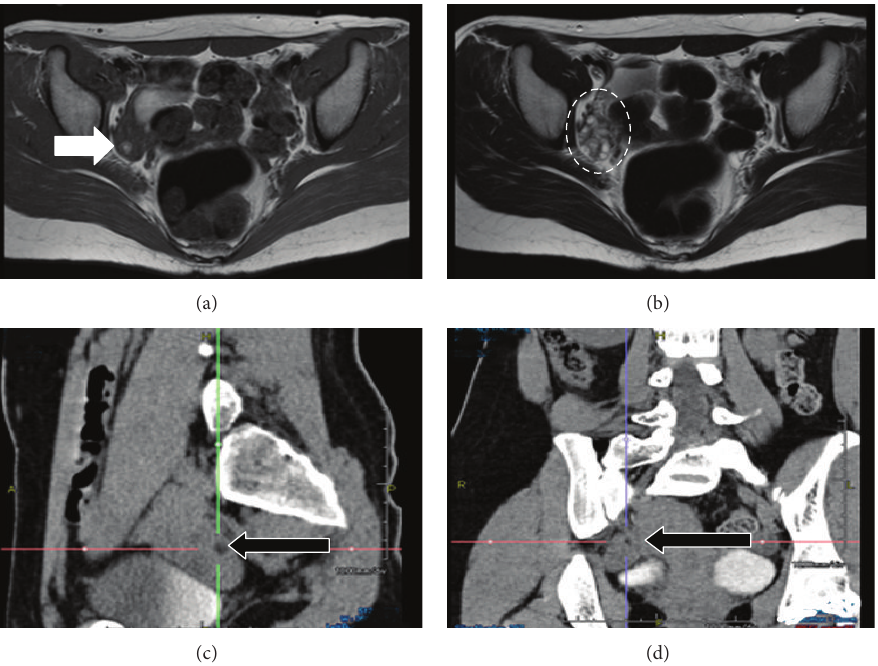
Figure 1: Image diagnosis. (a) T1-weighted transverse pelvic MRI; open arrow indicates a 5×7 mm high-intensity area in the right ovary that shows a fat component of the ovarian teratoma. (b) T2-weighted transverse pelvic MRI; broken-lined circle indicates the right ovary, which contains many antral follicles of the same size as the teratoma. ((c), (d)) Abdominal enhanced CT with 1mm slice thickness in a sagittal plane (c) and in a coronal plane (d); closed arrow indicates a 5 × 7 mm low-density area in the right ovary that shows a fat component of the teratoma. The mean CT number was − 62.5